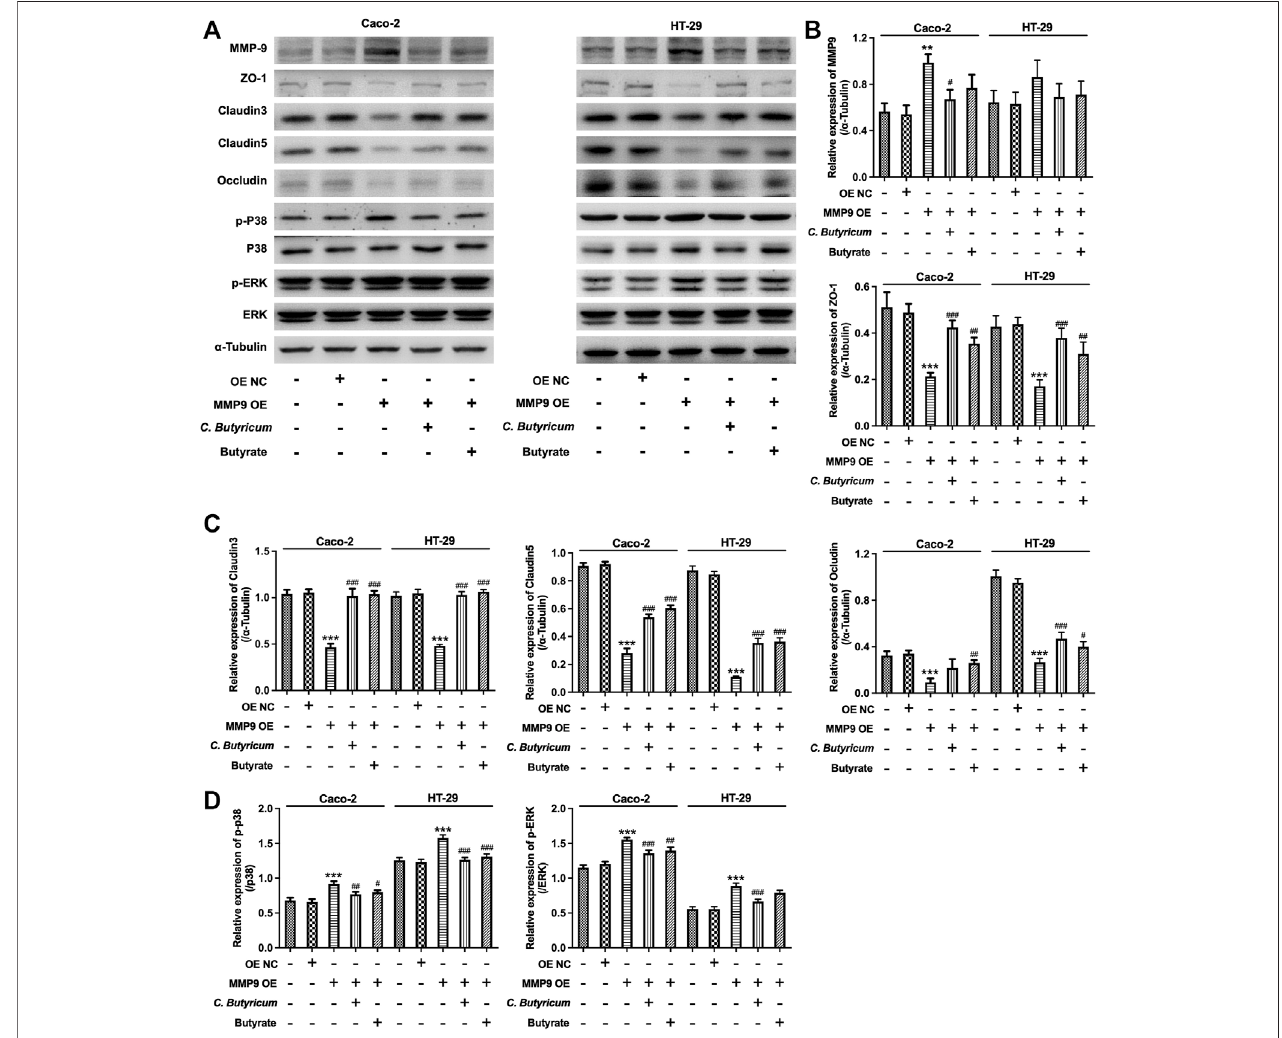
FIGURE 5 | Clostridium butyricum or butyrate treatment protected MMP9-induced the destruction of intercellular tight junction in Caco-2 and HT-29 cells. (A – D) Caco-2 and HT-29 cells were transfected with MMP9 OE plasmids. The transfected Caco-2 and HT-29 cells were then treated with butyrate (2 mM for Caco-2 cell and 1 mM for HT-29 cell) for 48 h. Meanwhile, the transfected Caco-2 and HT-29 cells were co-cultured with C. butyricum (1 × 10 8 CFU/ml) for 6 h in an anaerobic environment. After that, the supernatant was removed, and cells were then cultured in normoxia environment for 48 h. Western blot assay was used to determine theexpressionsofMMP9, ZO-1,Claudin3, Claudin5, p-p38,p-ERK incells. ** p < 0.01,*** p < 0.001vs. controlgroup; # p < 0.05, ## p < 0.01, ### p < 0.001vs.